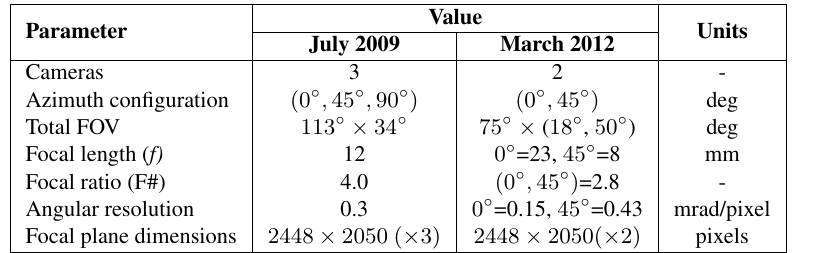
Table 2: Cerberus Array